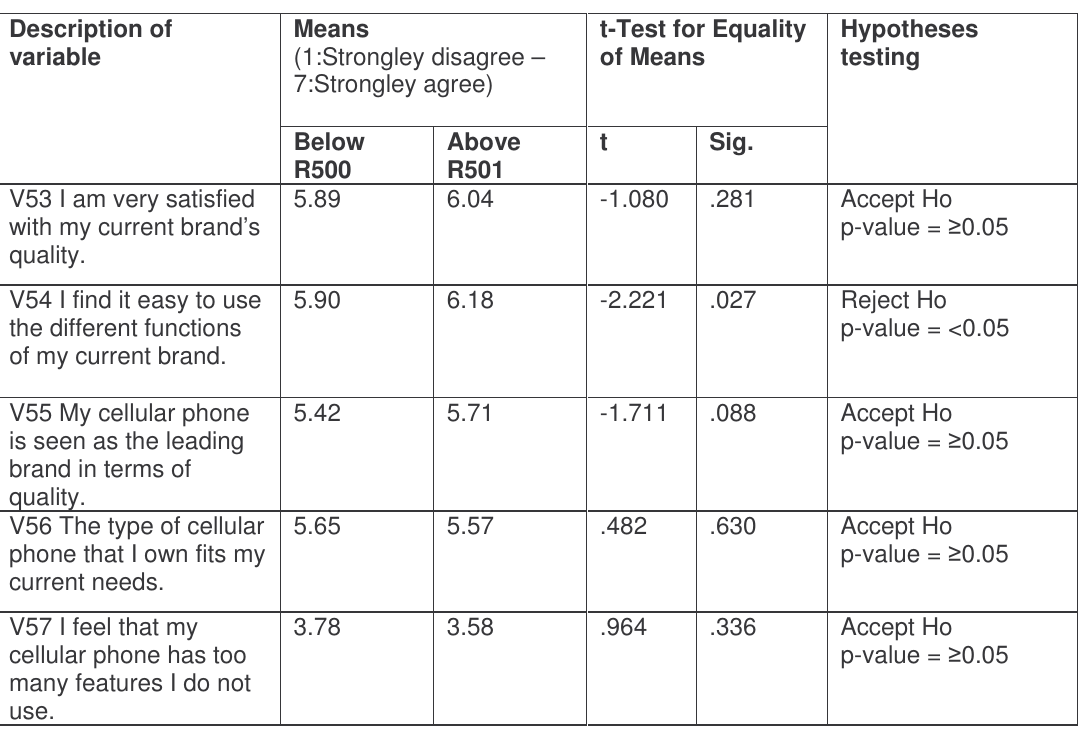
Table 4: t-Test results for students’ (with a monthly income up to R500 and monthly income of R501 and more) perception of the relationship between brand name and the quality of cellular phones.